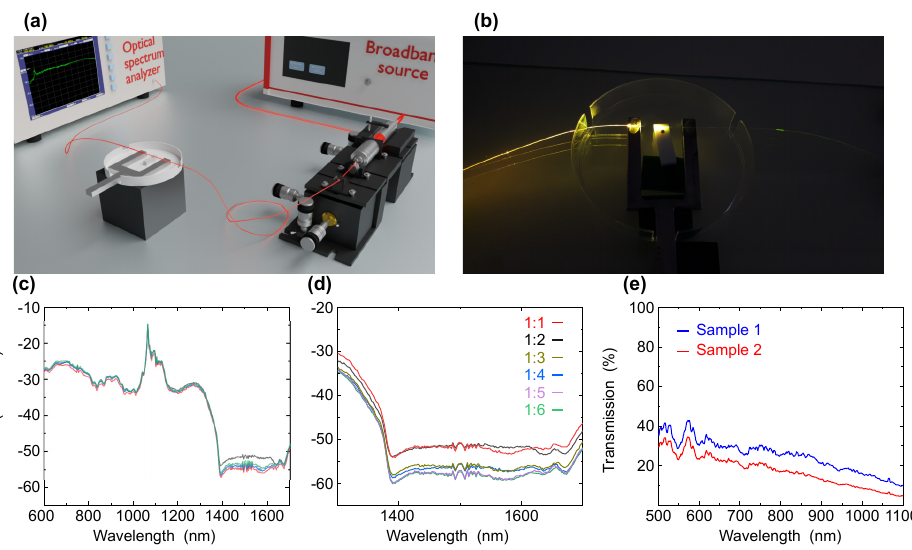
Figure 5. ( a ) Experimental setup used in the tapered fiber experiment. ( b ) The tapered fiber structure with the sample on the Teflon spacer. ( c ) VIS-NIR spectra of graphene and graphene with gold nanoparticles in cuvette at wavelength range of 600–1700 nm and ( d ) zoom-in intersection region at wavelength range of 1300–1700 nm with ratio of graphene to gold nanoparticles of 1:1, 1:2, 1:3, 1:4, 1:5 and 1:6. ( e ) Spectra of graphene overlayers on tapered fibers based on graphene form of shungite and gold nanoparticles at wavelength range of 500–1100